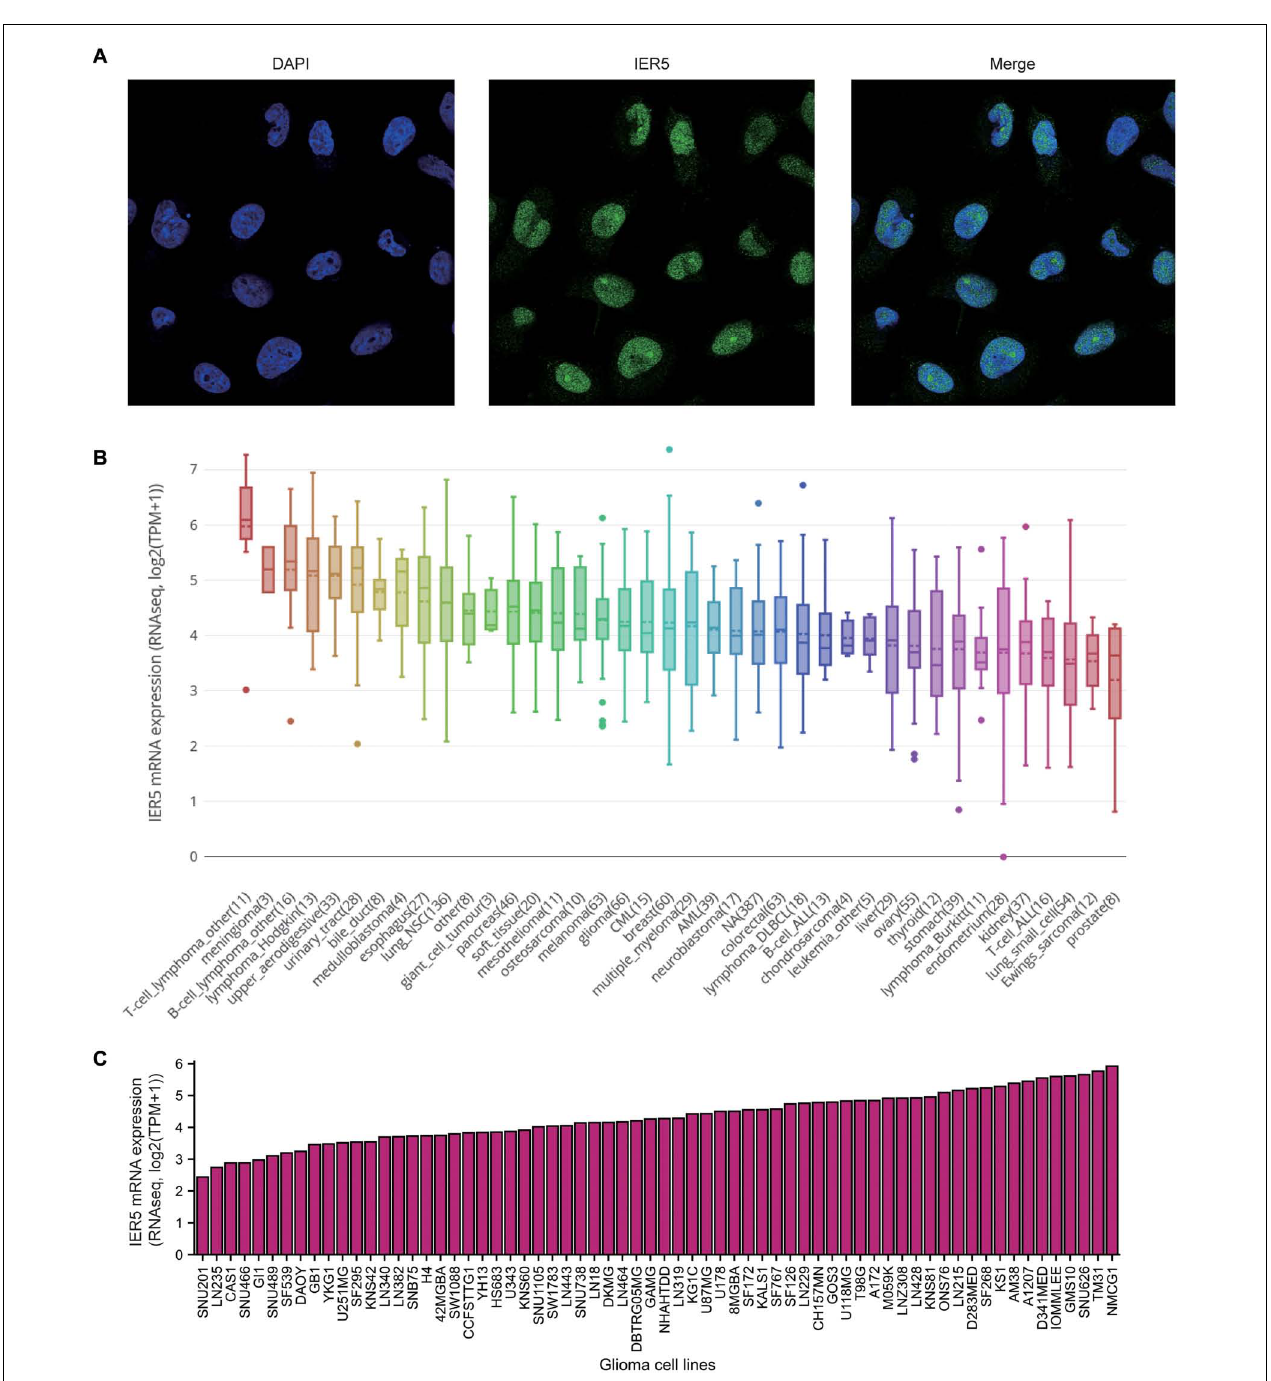
FIGURE 2 | Expression of IER5 at protein levels in U251 cell lines and at mRNA levels in different glioma cell lines. (A) Gene expression of IER5 was identified using immunofluorescence in U251 cell lines, these data are from The Human Protein Atlas databases. (B) IER5 expression patterns in 1457 cell lines representing 40 distinct tumor types, these data are from The Cancer Cell Line Encyclopedia (CCLE) databases. (C) IER5 expression patterns in 66 glioma cell lines, these data are from CCLE databases.